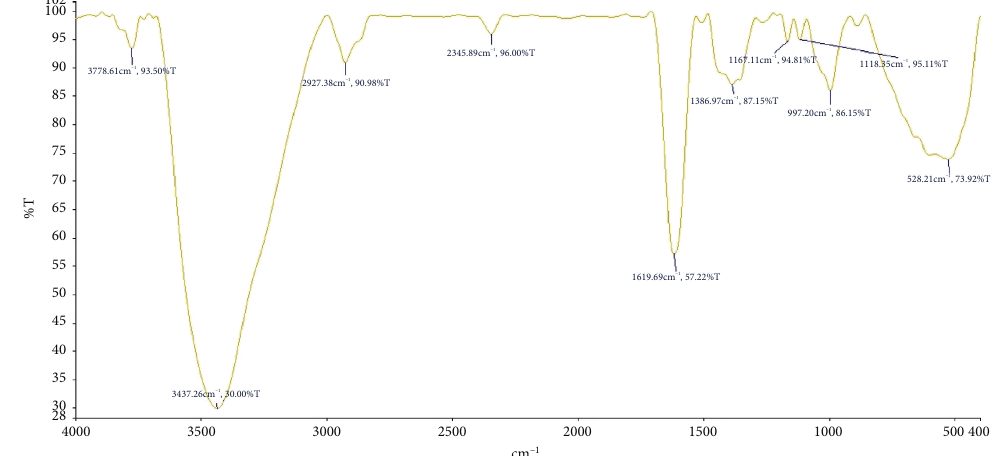
Figure 2: Recorded FTIR spectrum of silver-doxycycline